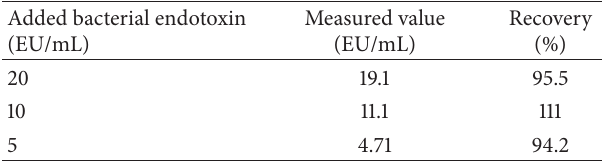
Table 3: Recovery of bacterial endotoxin in the aqueous extracts.